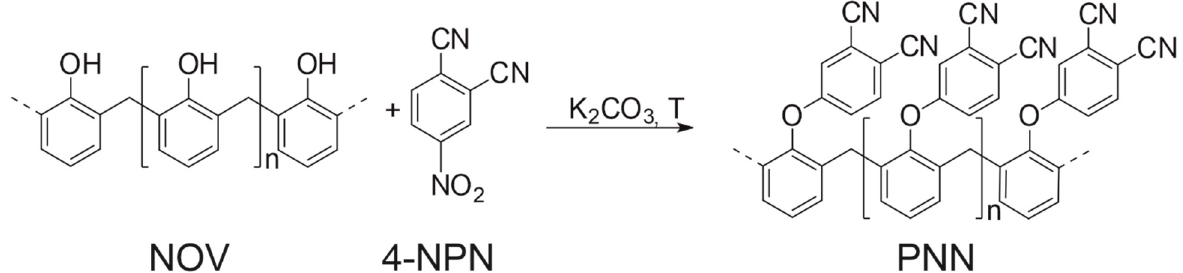
Figure 1. Scheme of PNN synthesis.